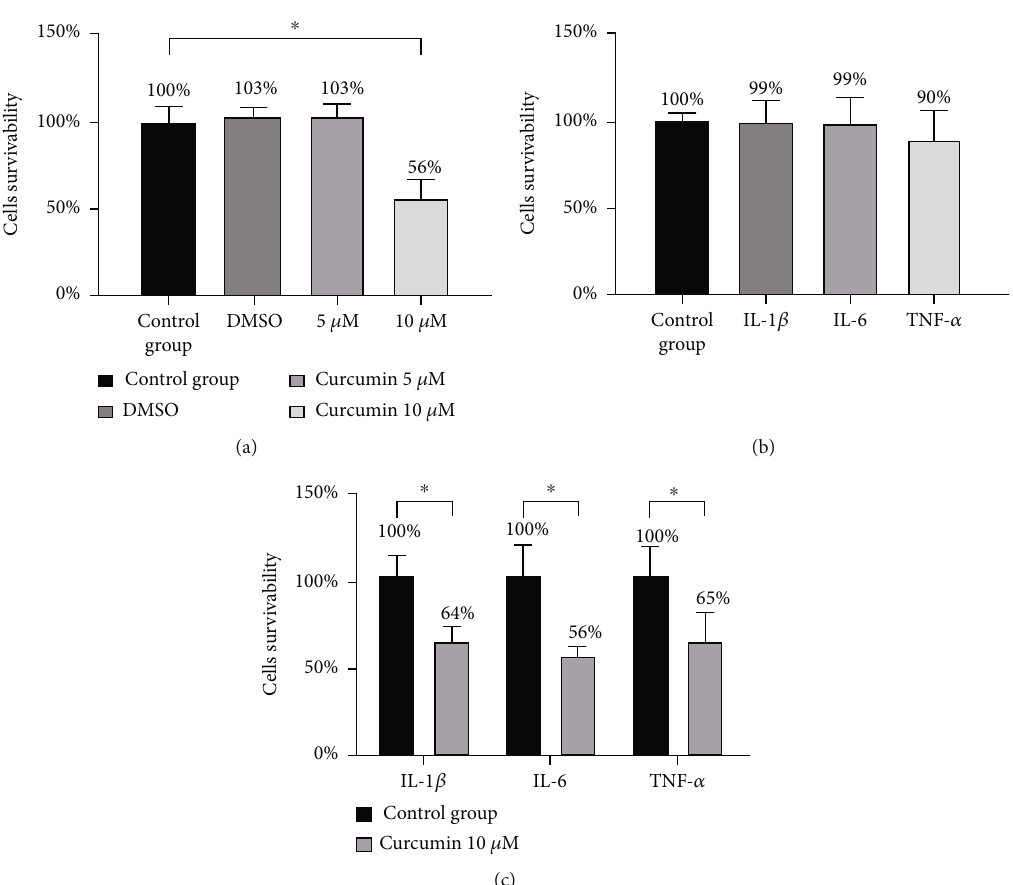
Figure 1: Comparison SW982 cell survivability after 24h incubation with (a) curcumin (5 μ M, 10 μ M) and DMSO; (b) IL-1 β , IL-6, and TNF- α at concentrations of 50ng/ml; and (c) curcumin (10 μ M) and IL-1 β , IL-6, and TNF- α (50 ng/ml). Results represent the mean from two di ff erent experiments from 5 wells, ∗ p < 0 : 05